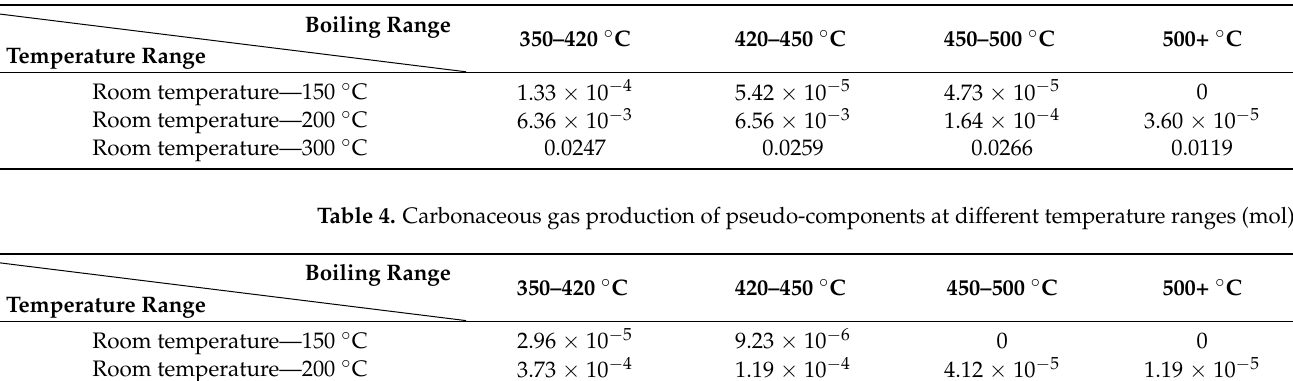
Table 3. Oxygen consumption of pseudo-components at different temperature ranges (mol).